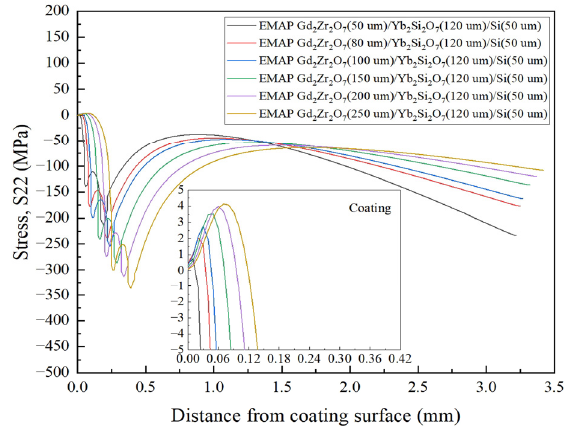
Figure 10. S22 stress distributions along right boundary path from surface to substrate at different EMAP Gd 2 Zr 2 O 7 layer thicknesses (h = 50, 80, 100, 150, 200, and 250 μ m). EMAP Gd 2 Zr 2 O 7 layer thicknesses (h = 50, 80, 100, 150, 200, and 250